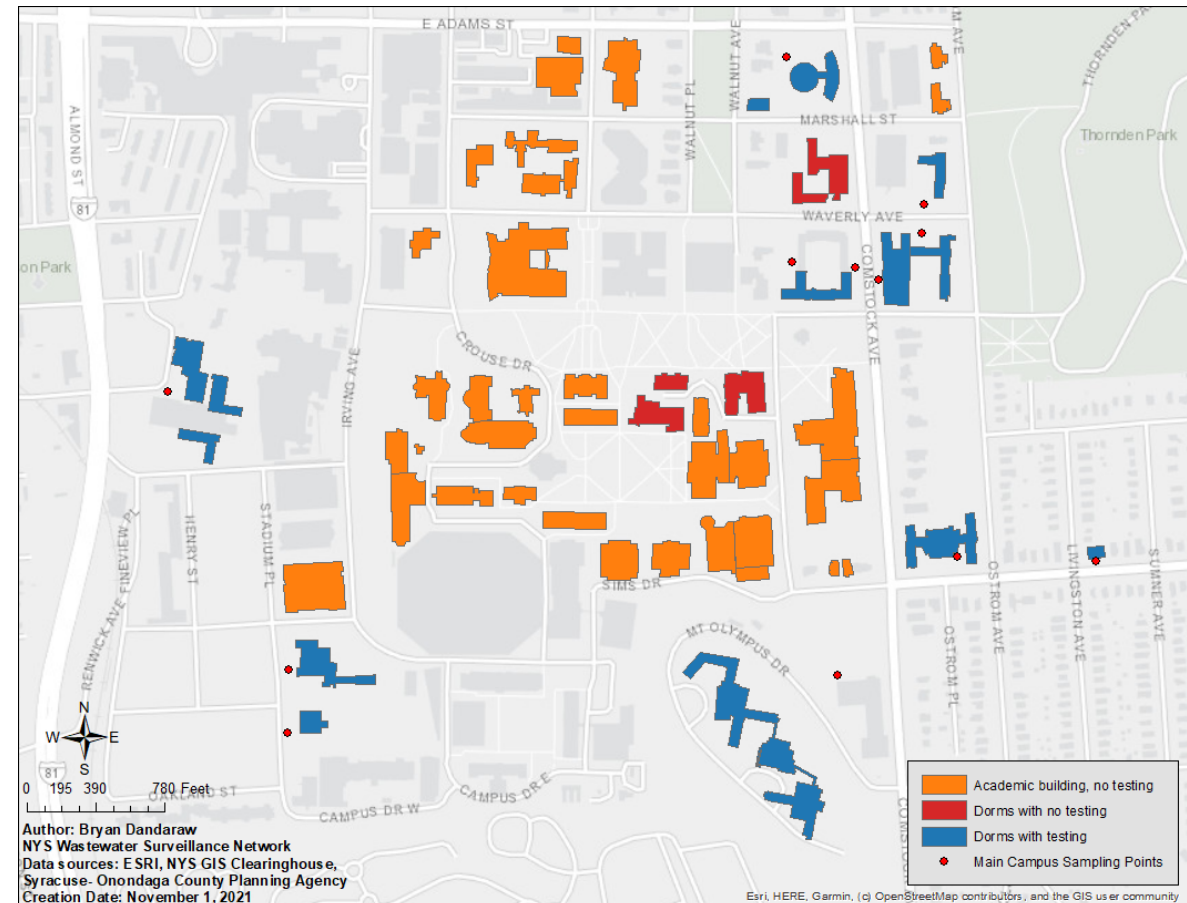
Figure 1. Syracuse University north campus. Buildings are classified as academic or residential (“dorms”) with or without testing fall